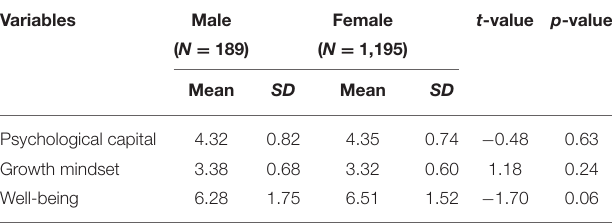
TABLE 2 | Gender difference between all variables ( n =